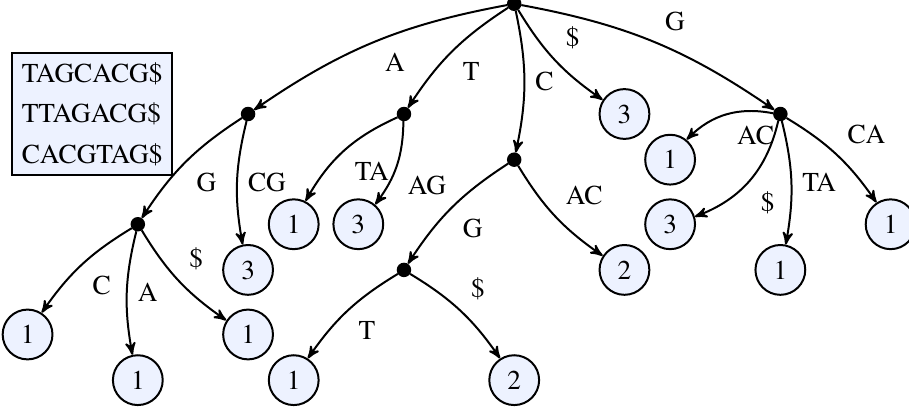
Figure 1. 3-truncated generalized suffix tree of the sequences TAGCACG , TTAGACG , and CACGTAG . The black dots represent the inner nodes and the light circles the leaf nodes. The number inside a leaf node shows the number of occurrences of the leaf’s path label in the input